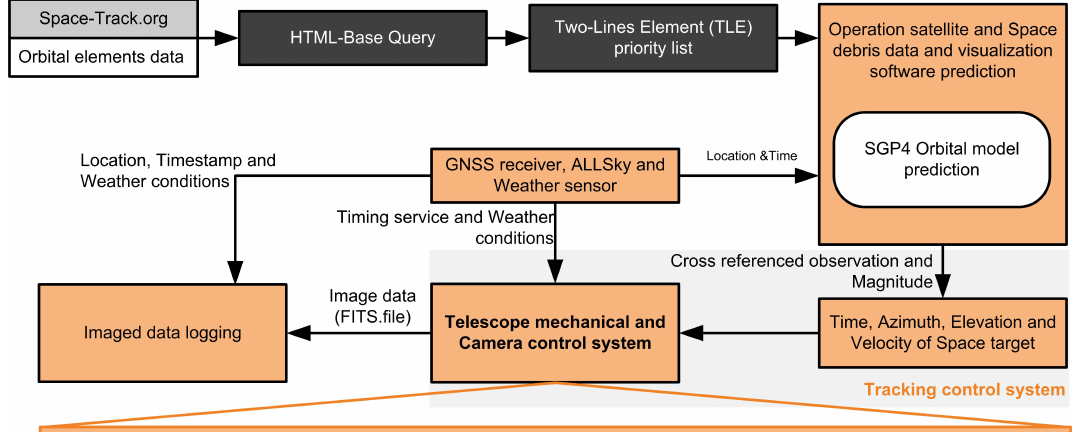
Figure 1. System architecture of Thai National Space objects Observation (TNSO)